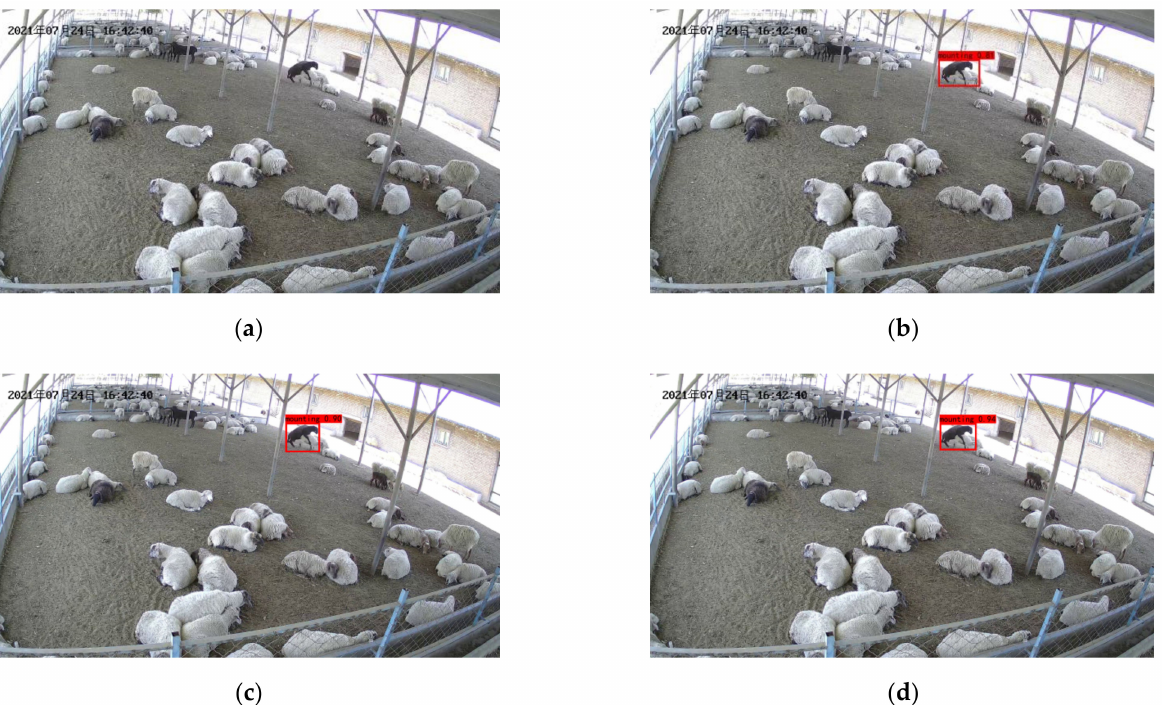
Figure 11. Analysis of mid-range detection results: ( a ) Original image; ( b ) YOLO v3 + EfficientNet-B0 recognition effect; ( c ) YOLO v3 recognition effect; ( d ) ES_YOLO v3 recognition effect. The Chinese in the upper left corner of the image is the date of the video recording, in order of year, month and